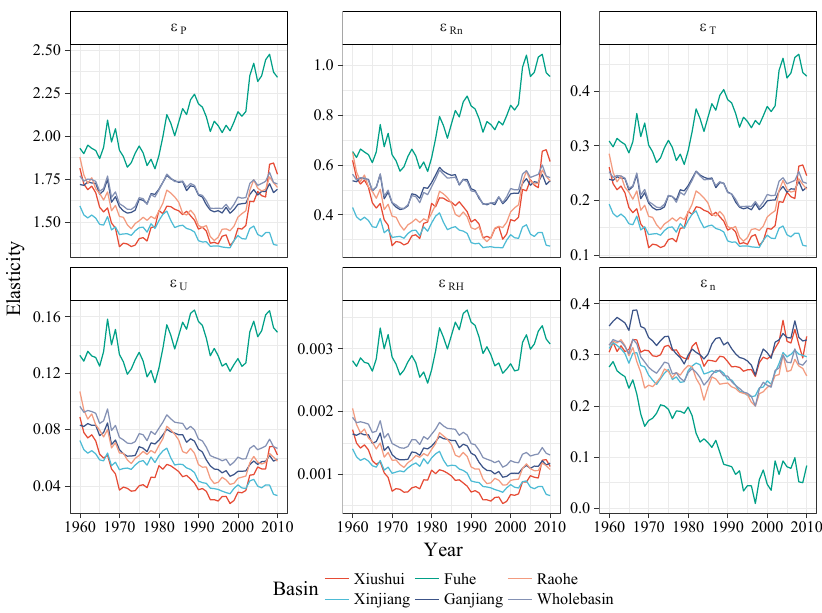
Figure 5. Temporal variation of climate elasticities across PYLB during 1960–2010. The annual value of elasticity was calculated by adapting the Budyko framework with a 10-year moving average, including the five antecedent and precedent years. (cid:101) P , (cid:101) Rn , (cid:101) T , (cid:101) U , (cid:101) RH and (cid:101) n represent precipitation elasticity, net radiation elasticity, temperature elasticity, wind speed elasticity, relative humidity elasticity and catchment properties’ parameter elasticity, respectively.